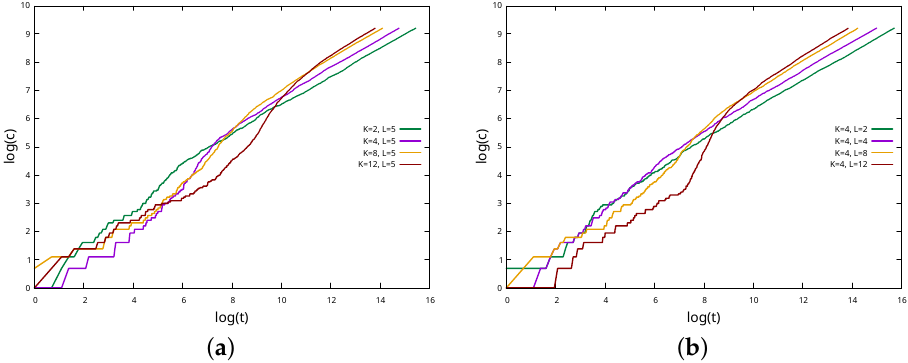
Figure 4. Logarithmic plot of the knowledge corpus c for N = 10,000. ( a ) Fixed L = 5 and five values of K . ( b ) Fixed K = 4 and five values of L .